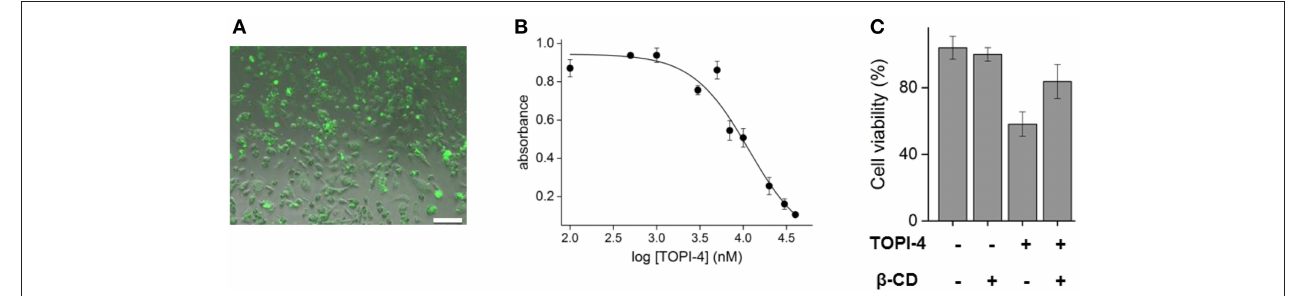
FIGURE 3 | (A) Fluorescence image of MDA-MB-231, overexpressing GST, incubated with TOPI-4 (10 µ M). The scale bar is 100 µ m. (B) Results of an MTT assay that measures the viability of MDA-MB-231 cells under increasing concentrations of TOPI-4. The absorption at 570nm reflects the number of viable cells. (C) Cell viability scores of MDA-MB-231 cells treated with TOPI-4 (10 µ M) and/or β -CD (750 µ M).